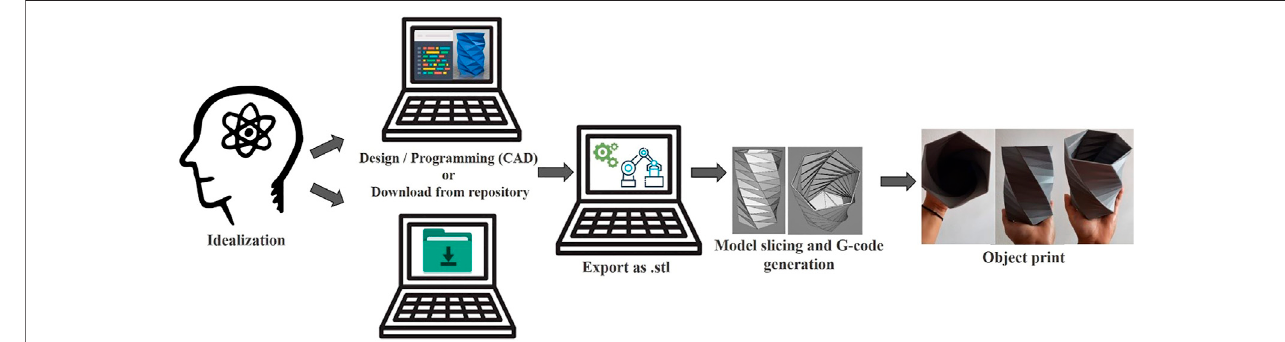
SCHEME 1 | Flowchart of the main stages of the 3D printing process.